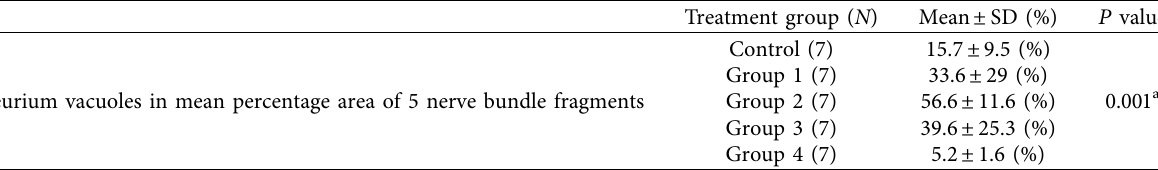
Table 3: Vacuole in cells on histopathologic analysis on each treatment